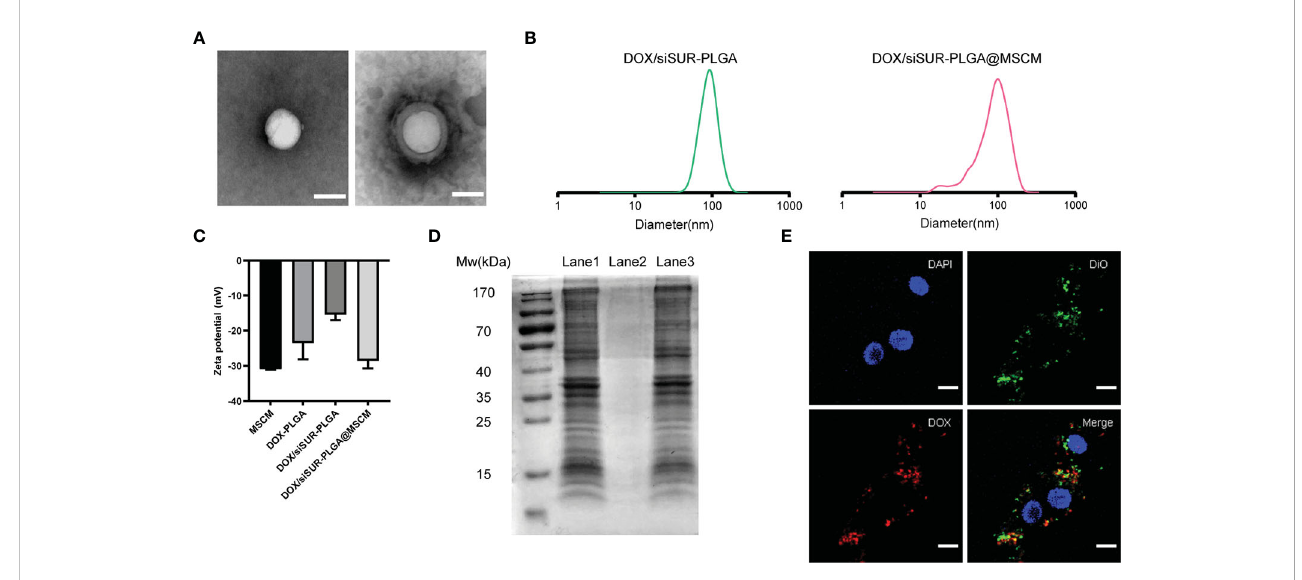
FIGURE 2 Characterization of the nanoparticles. (A) TEM images of DOX/siSUR-PLGA NPs (left) and DOX/siSUR-PLGA@MSCM NPs (right). Scale bar, 100 nm. (B) Size of DOX/siSUR-PLGA NPs (left, green) and DOX/siSUR-PLGA@MSCM NPs (right, red). (C) Zeta potentials of the prepared nanoparticles. (D) Analysis of the proteins in the lysates of MSC membranes (Lane 1), DOX/siSUR-PLGA NPs (Lane 2) and DOX/siSUR-PLGA@MSCM NPs (Lane 3) by SDS − PAGE. (E) Intracellular colocalization of MSC membranes (DiO, green) and DOX/siSUR-PLGA NPs (DOX, red). MG63 cell nuclei were stained with DAPI (blue). Scale bar, 20 m